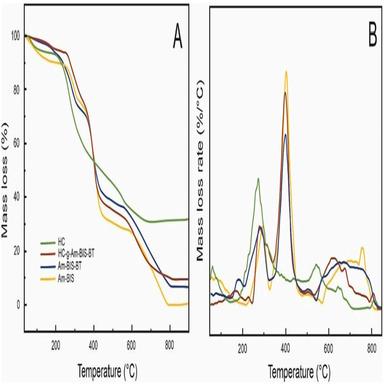
A: TGA, and B: DTG the of HC and modified HC and hydrogels.